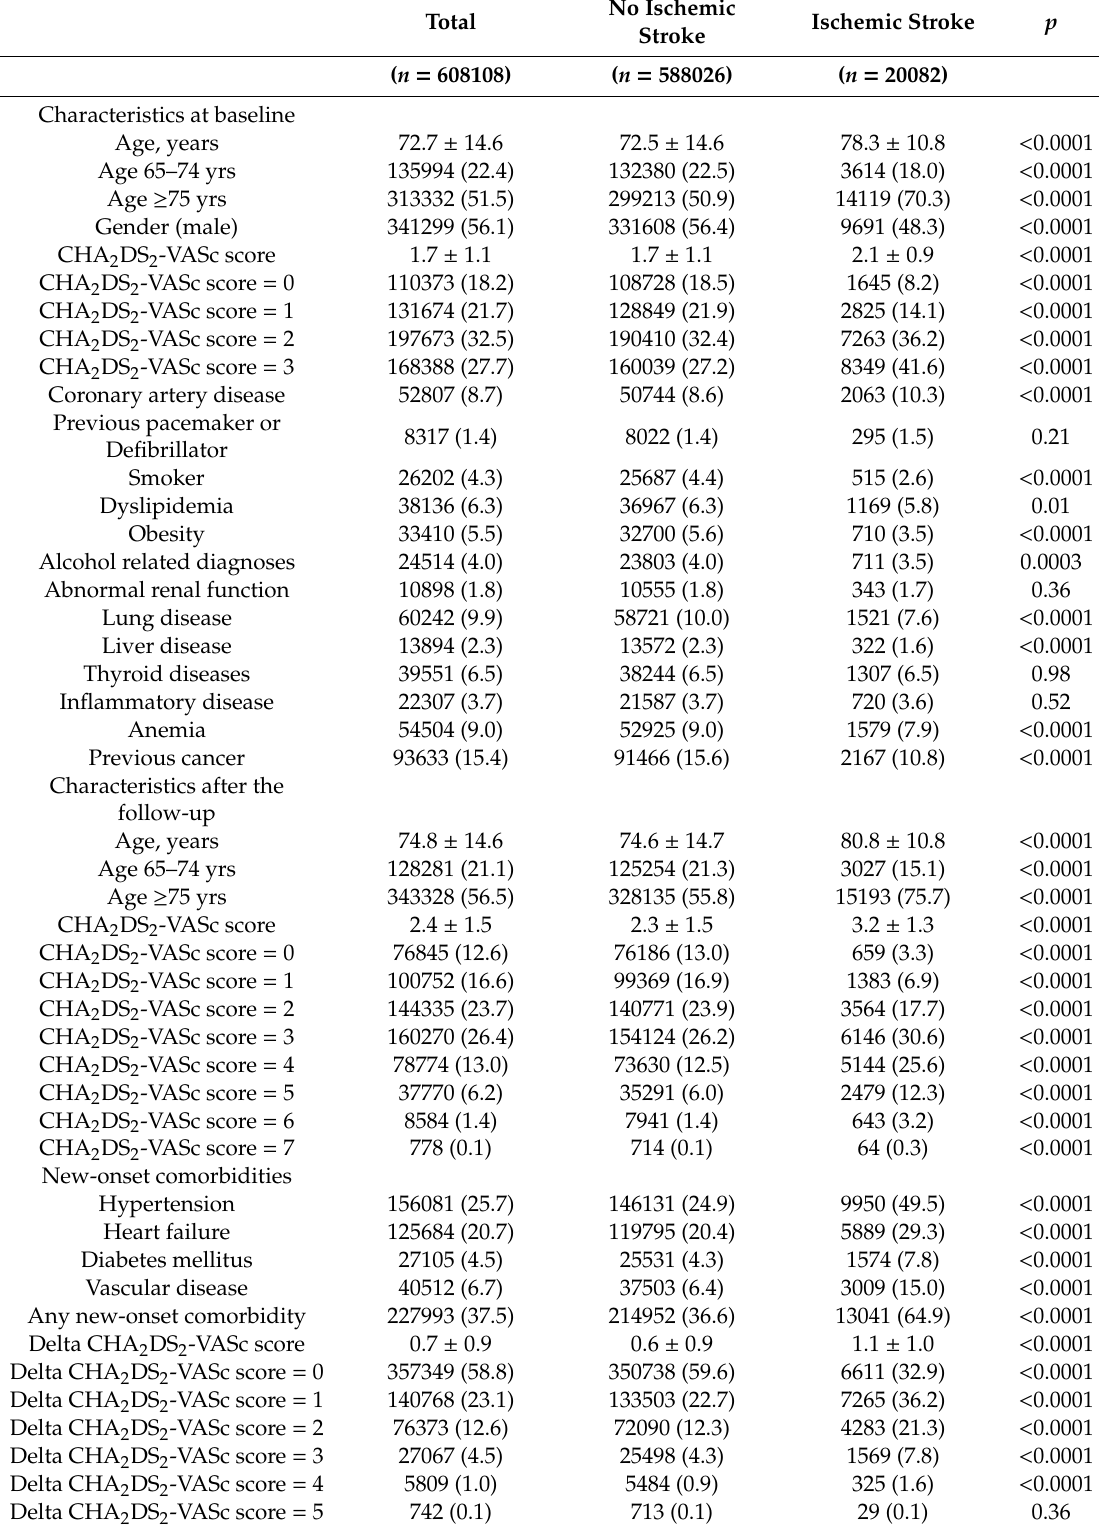
Table 1. Baseline characteristics of AF